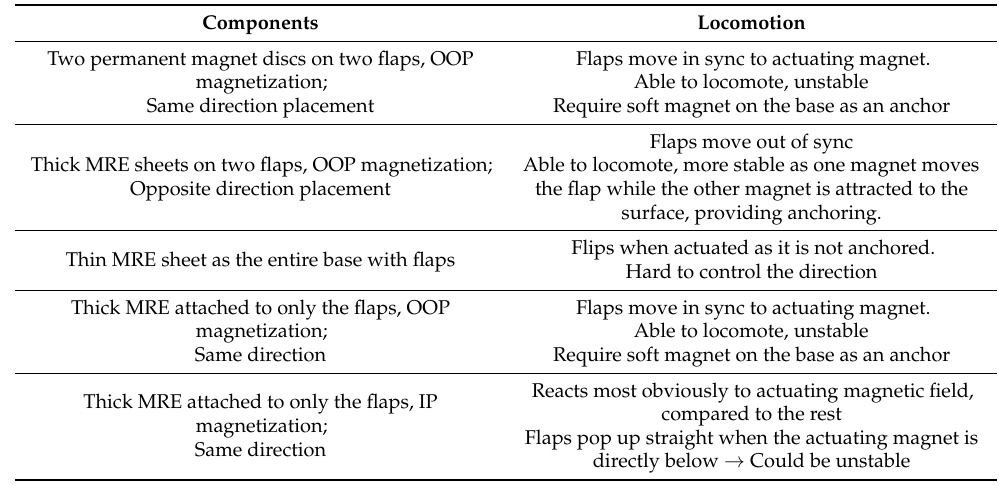
Table 2. Combinations of magnets and magnetization direction and observations from their